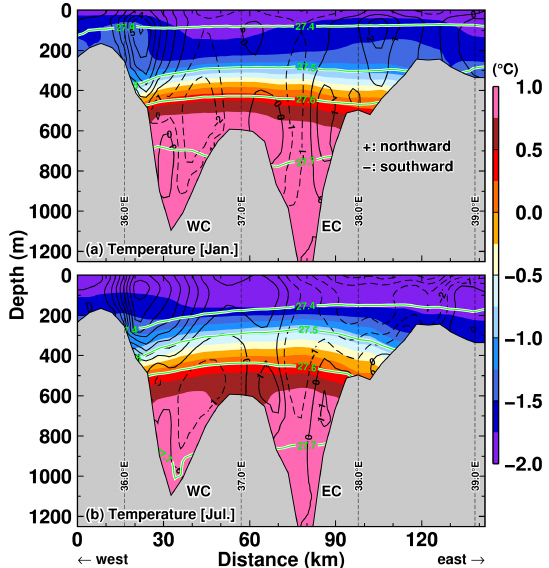
Figure 15. Vertical profiles of potential temperature along the sill section (at 68.5 ◦ S) in (a) January and (b) July in the NOFI case, with the velocity normal to the section (cms − 1 ). Positive veloc- ity indicates northward flow. Green curves indicate the contours of potential density anomalies. The model’s variables were averaged over the period 2008–2018. The horizontal axis indicates the dis- tance from the western side starting point of the sill section (see the line of the sill section in Fig.